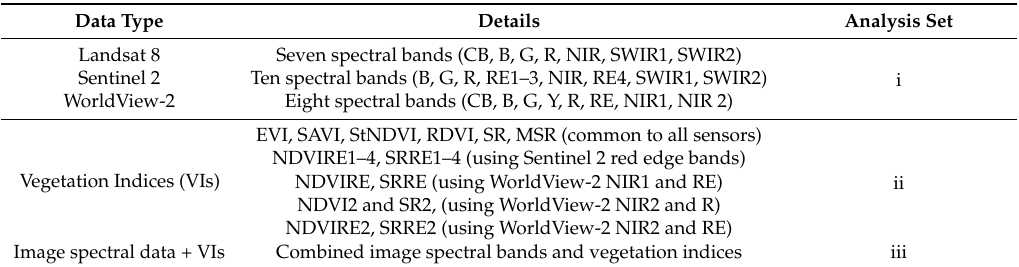
Table 2. Remote sensing variables used to predict species AGB for C3 and C4 grass species